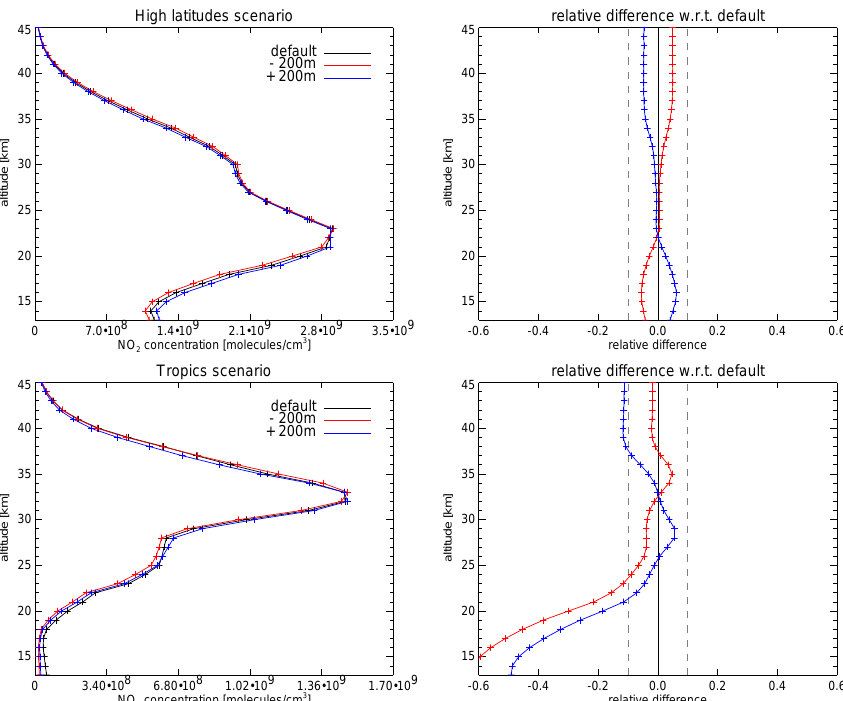
Fig. 4. Influence of the pointing errors on the retrieval results for northern high latitudes (upper panels) and tropics (lower panels), 18 June 2005. Left panels show the retrieved profiles for shifted ± 200m and unperturbed tangent heights. Right panels show the corre- sponding relative